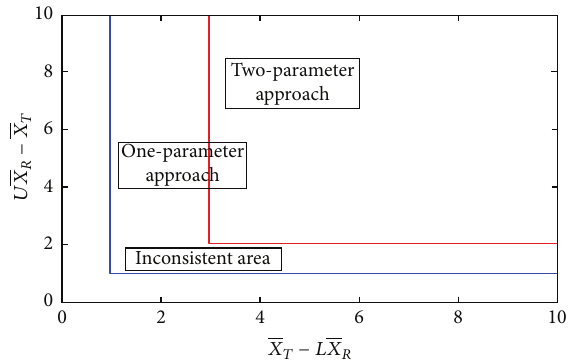
Figure 3: Comparison of two approaches’